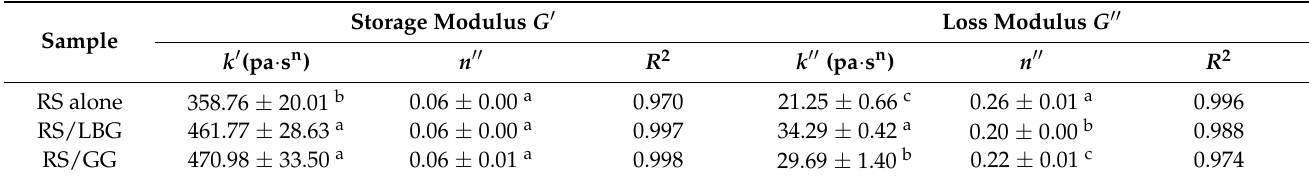
Table 3. Parameters of RS alone, RS containing locust bean gum (RS/LBG), and RS containing guar gum (RS/GG) at 25 ◦ C as determined from Equations (1) and (2) *.